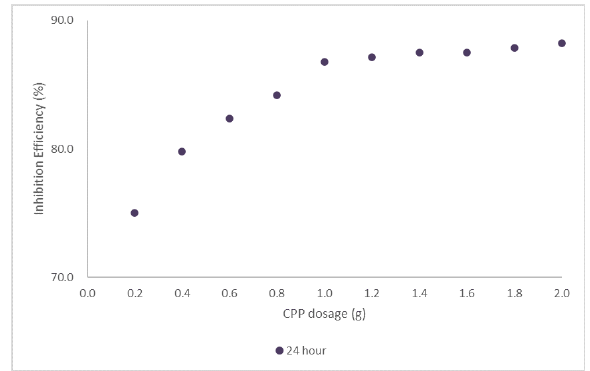
Fig. 6. Optimization of CPP inhibitor at 24-hour immersion time.